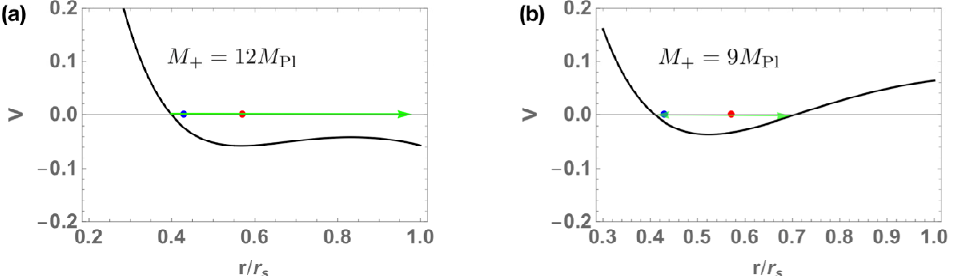
Figure 7 . (a) shows the trajectory of the growing bubble with M + > M C and (b) shows the oscillatory trajectory of the vacuum bubble trapped around the inner and outer horizons. Both trajectories are depicted with green arrows, and red and blue points represent the position of the outer and inner horizons,